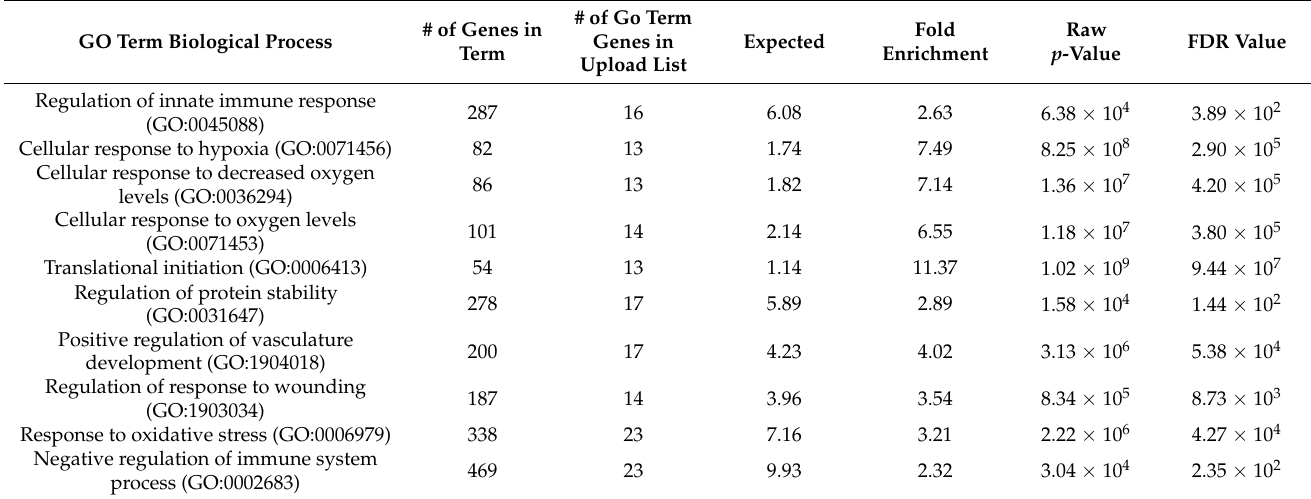
Table A2. Selected GO terms (Figure 1E) enriched in efferocytic bone marrow macrophages.